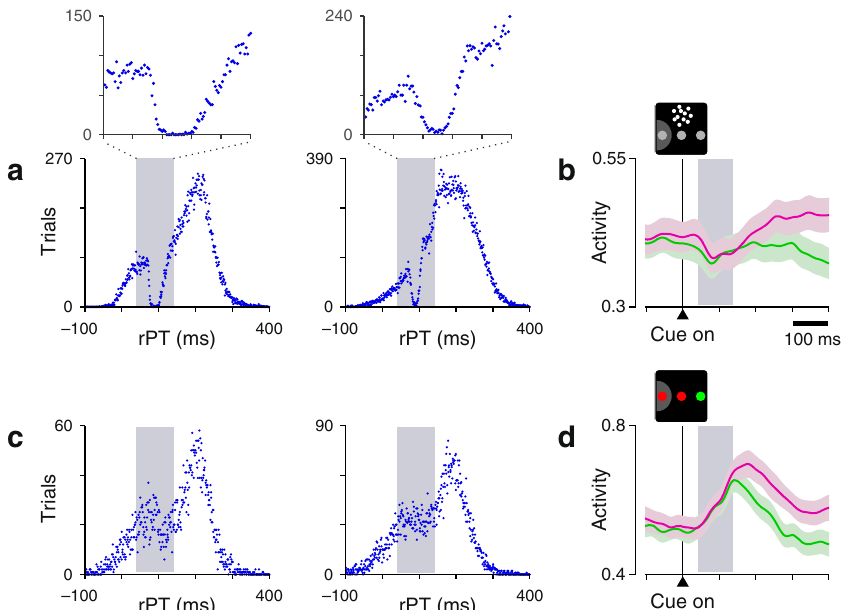
Fig. 4 | Evidence of spatial con fl ict in the CRDM task. a Processing time dis- tributionsfromtheCRDMbehavioralsessionsofmonkeysC(left,30,473trials)and T(right,52,945trials).Histogramswerecomputedusingnon-overlapping1msbins, so each point indicates the number of trials obtained with a given integer rPT. The data comprise correct and error trials from all coherences. Insets zoom in on the rPTrangeof40 – 140ms.Notethenearlycompleteabsenceofeventsat80 – 100ms. b Neuronalresponsetothemotiononsetinthenon-urgentRDMtask.Tracesshow normalized fi ring rate (mean±1 SE across cells) as a function of time for correct